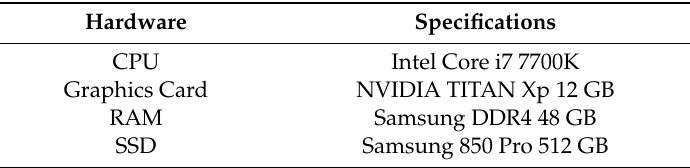
Table 1. Hardware specifications.